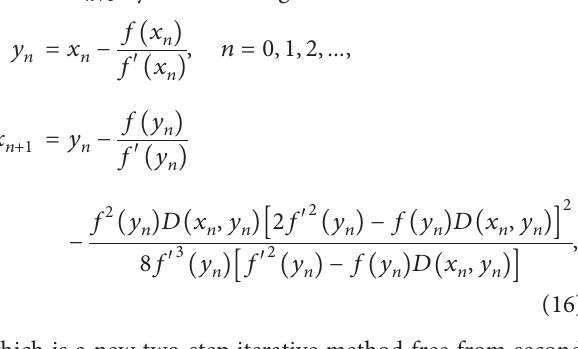
Algorithm 2. For a given x , compute the approximate 0 solution x by the following iterative n +1